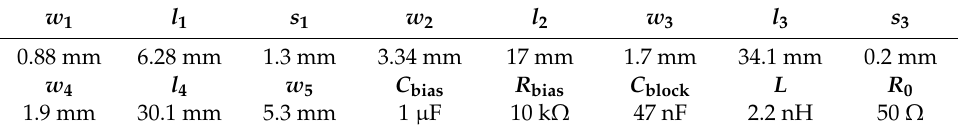
Table 2. Values of components and the main optimized dimensions of the